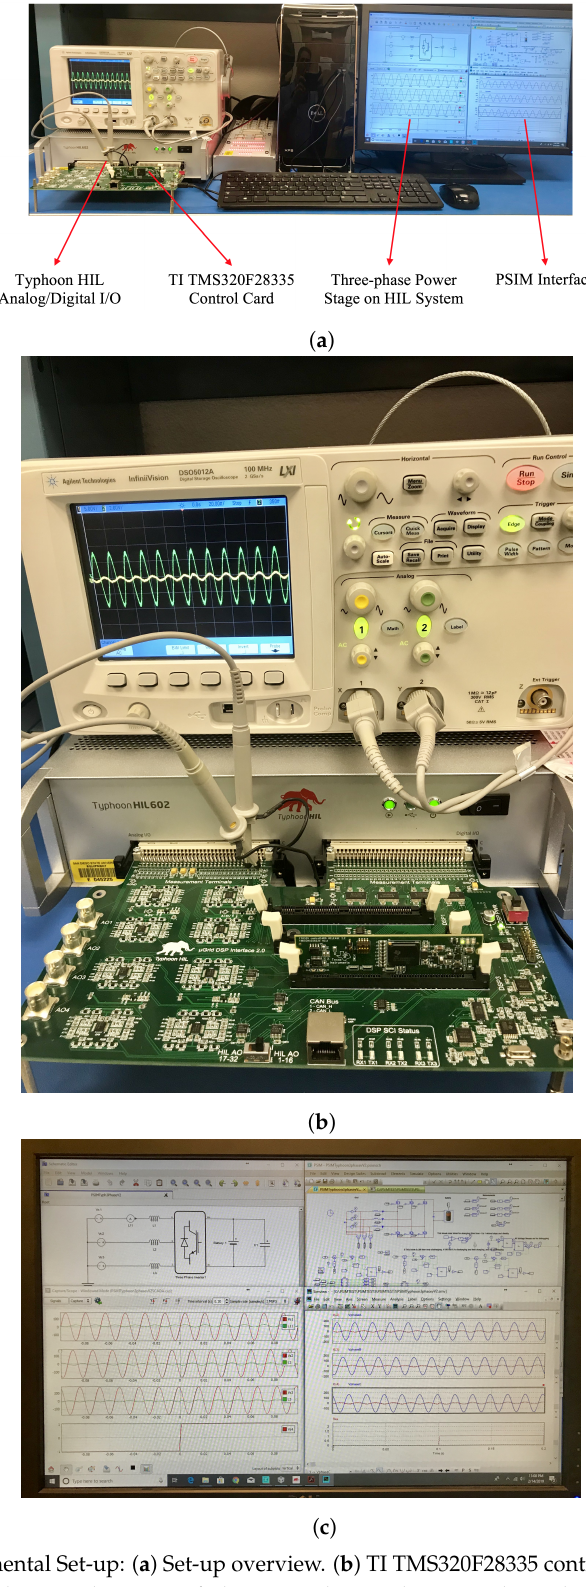
Figure 8. Experimental Set-up: ( a ) Set-up overview. ( b ) TI TMS320F28335 control card and oscilloscope showing input voltage and current of phase-a with step change in desired resistance from − 10 Ω to 10 Ω . ( c ) PSIM interface and implemented power stage on the hardware-in-the-loop (HIL)